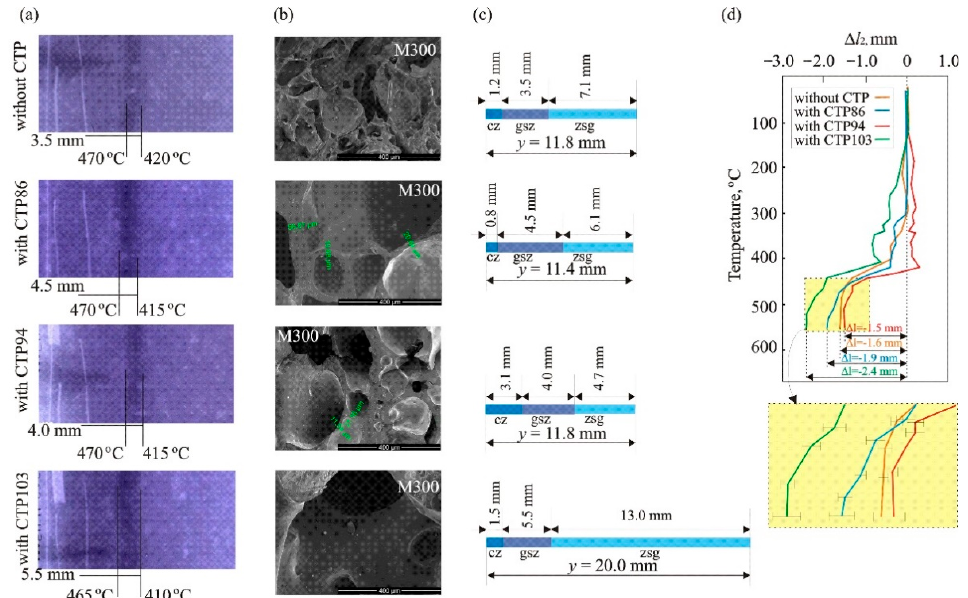
Figure 2. Results obtained during carbonization of coal and its blends with CTPs: ( a ) X-ray films of carbonized charge; ( b ) SEM images of gas-saturated zones in carbonized charge; ( c ) composition of plastic layers in carbonized charge; ( d ) changes in position of the marker in the charge of carbonized coal and its blends with CTPs.